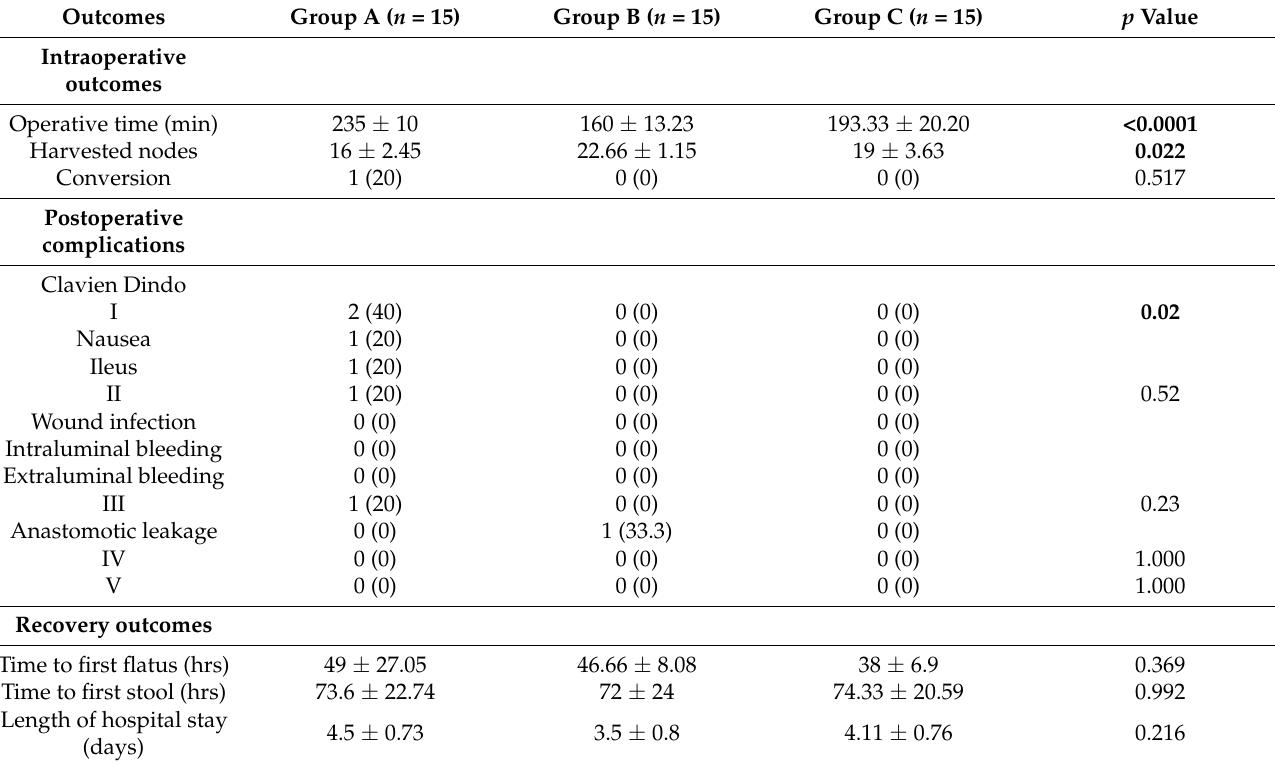
Table 4. Intraoperative outcomes, postoperative complications and recovery outcomes on left hemicolectomies.